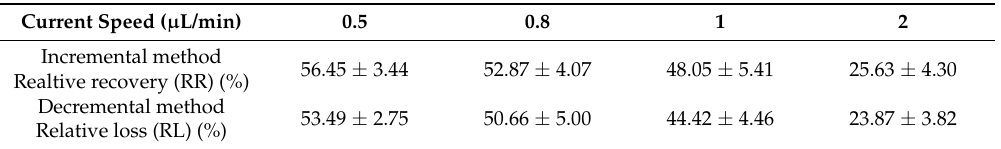
Table 1. Effects of perfusion flow rate on the recovery by gain and by loss from the knee-joint microdialysis probes in vitro ( n = 4, x ± s